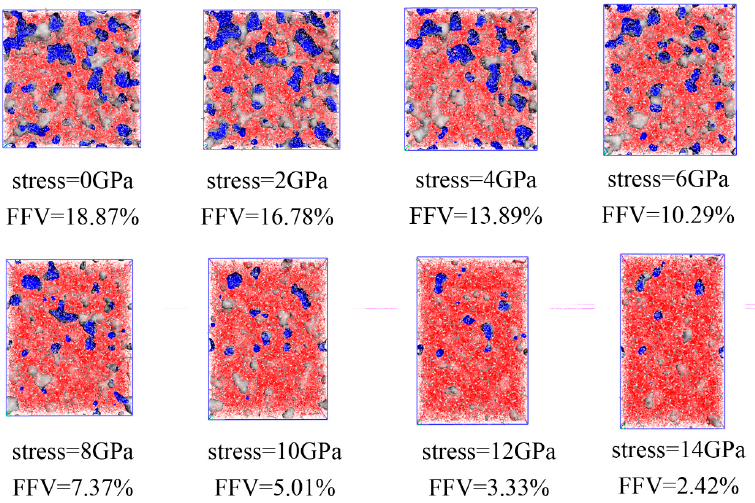
Figure 9. The volume change of EPDM during compression, showing the compression of EPDM from 0 to 14 successively. The blue area represents the surface of free volume through the pore channel, the white area is the pore space, the gray area is the skeleton of the pore channel, and the red area is the occupied volume.